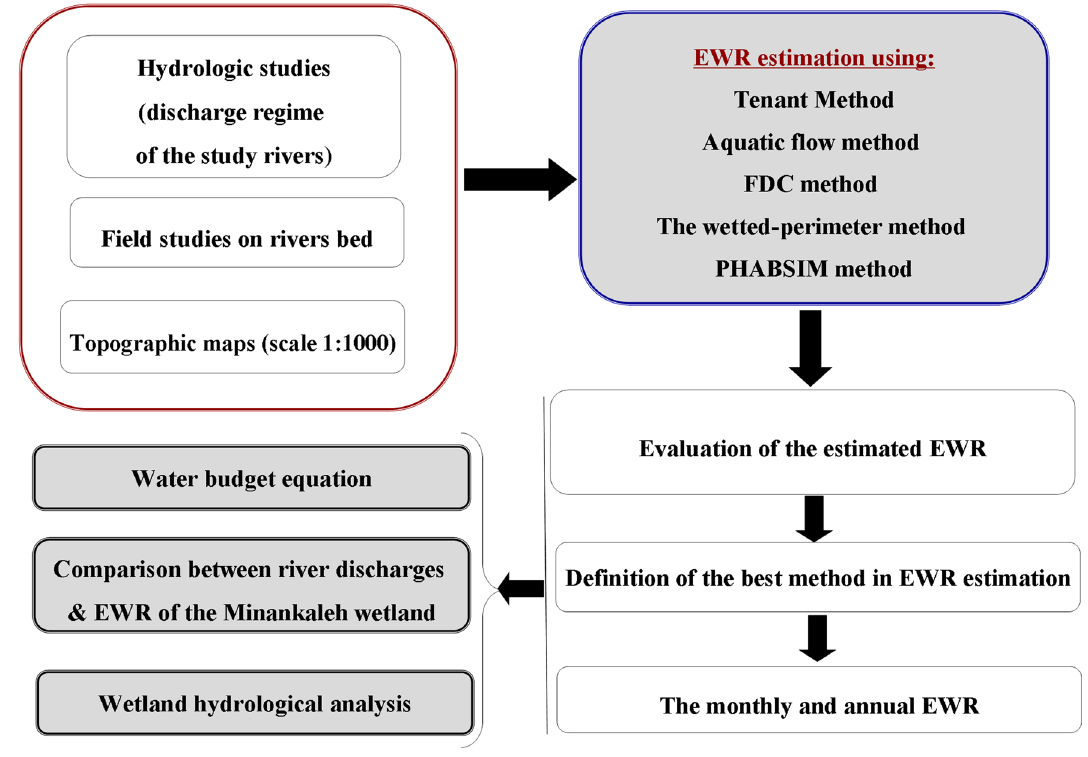
Fig. 2 The workflows of EWR estimation and the used